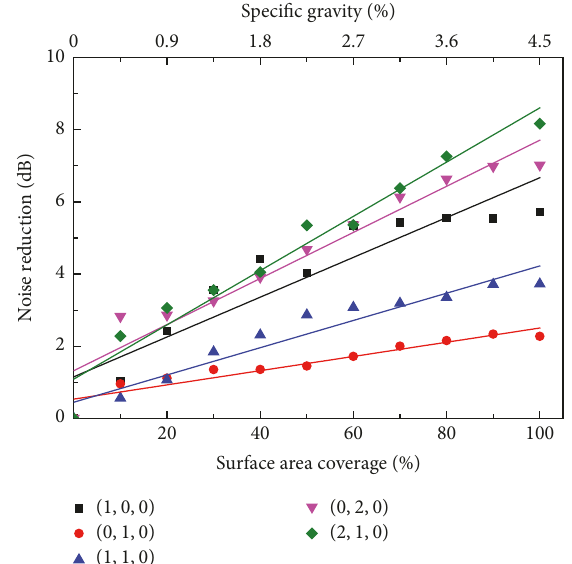
Figure7:Curvesofnoisereductionwithchangingoflayingrateand proportion (20mm).